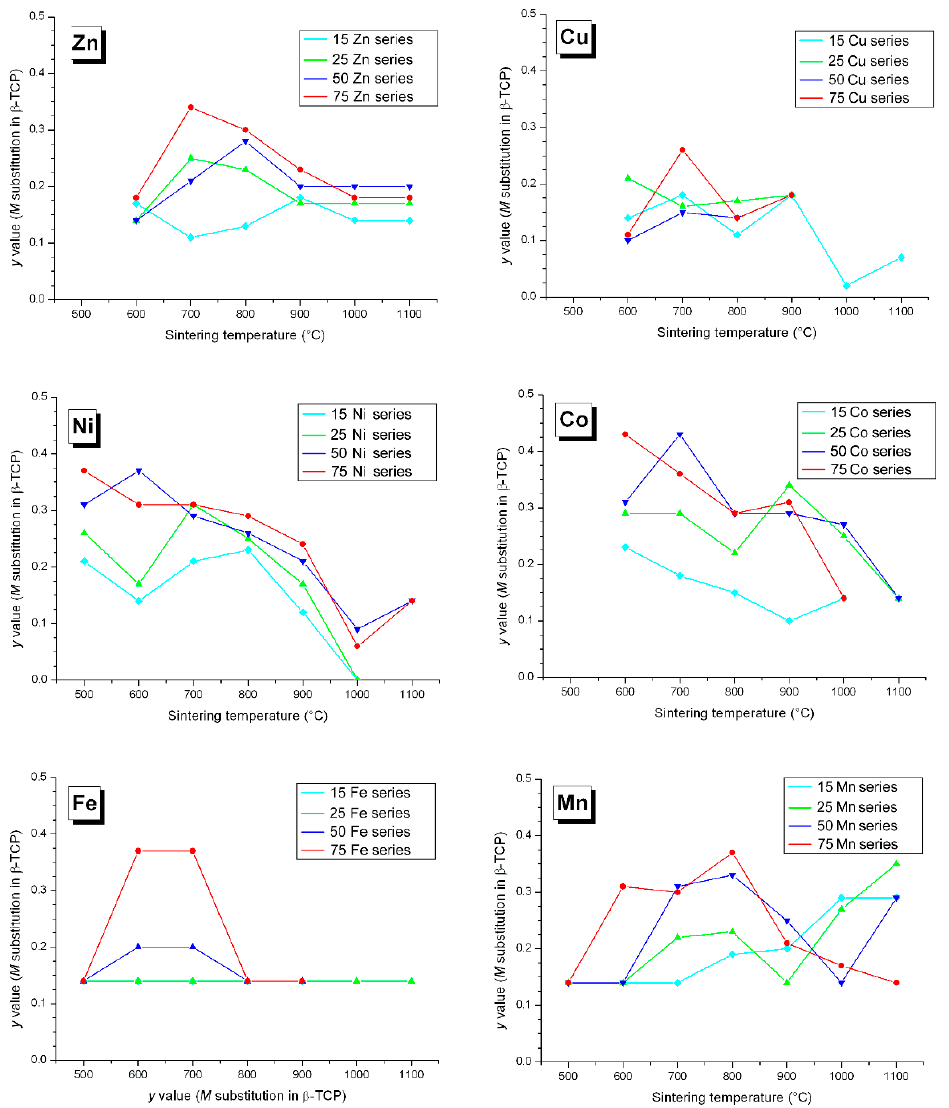
Figure 6. Variation in the y refined substituted M amount in the β -TCP structure, considering the Ca 3 − y M y (PO 4 ) 2 composition, for all Zn-, Cu-, Ni-, Co-, Fe-, and Mn-doped samples: light blue lines for the 15 M -T series, green lines for the 25 M -T series, dark blue lines for the 50 M -T series, and red lines for the 75 M -T series. The lines are only visual guides.